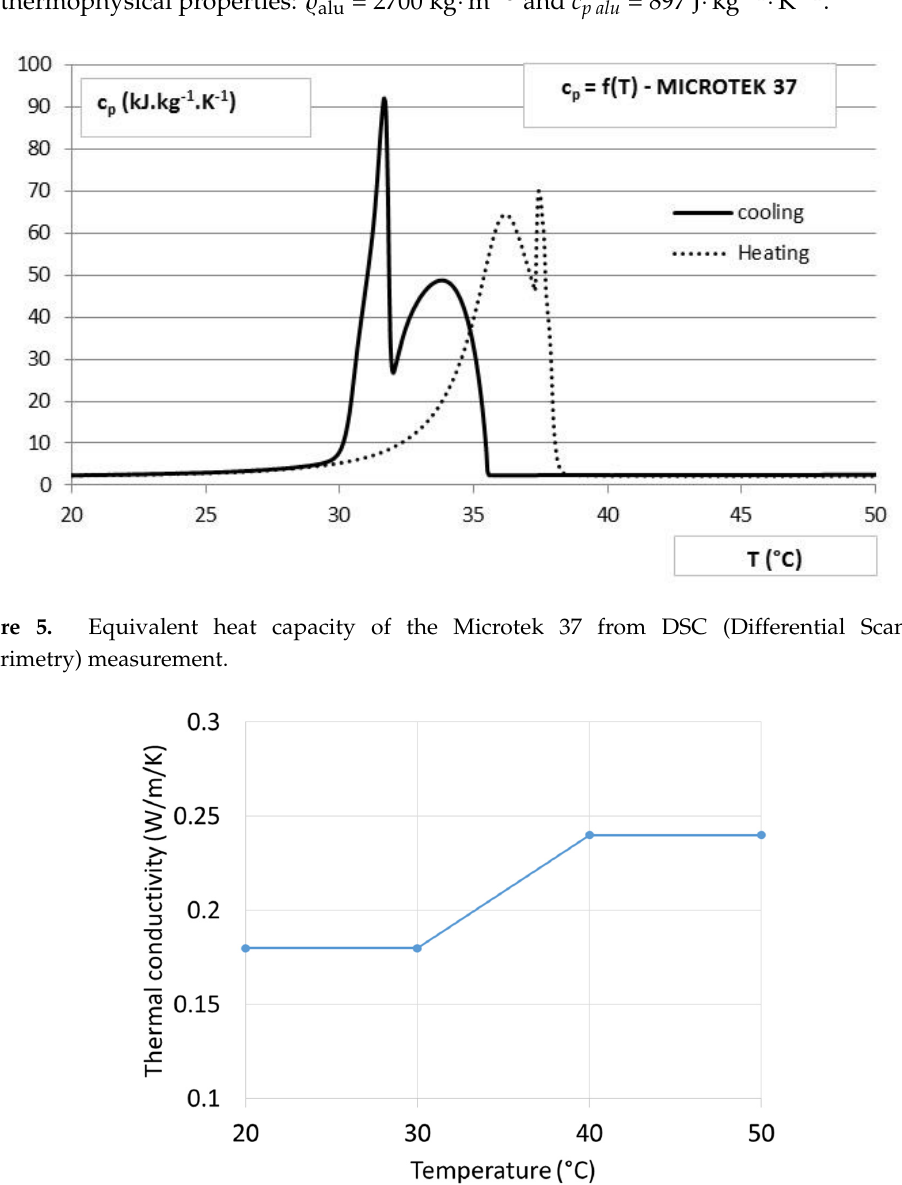
Figure 6. Thermal conductivity of PCM in the model.